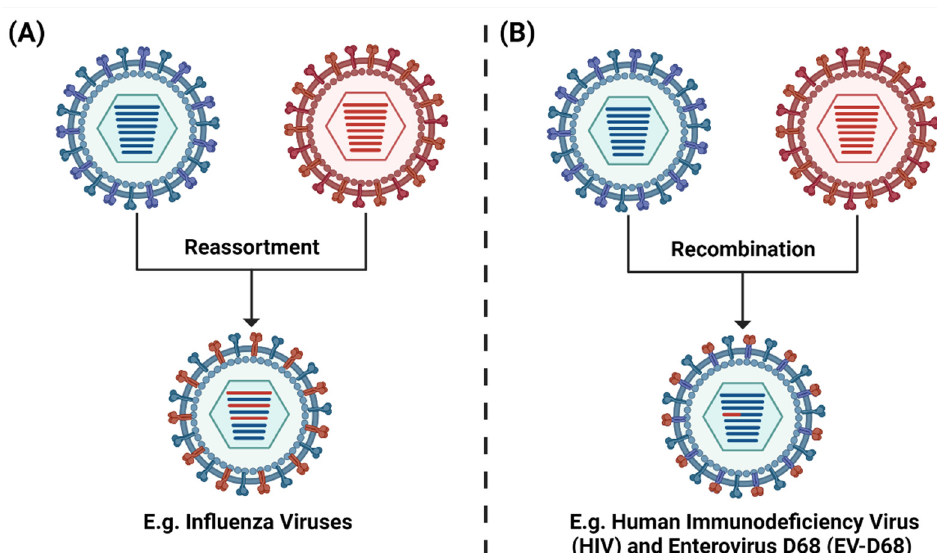
Figure 6. Modes of genetic modification by viruses. ( A ) Reassortment, which only occurs in segmented RNA viruses such as Influenza viruses where two antigenically distinct IAVs co-infect a common cell and reassort their genome segments. ( B ) Recombination, which occurs in all RNA viruses such as Human Immunodeficiency Virus (HIV) and Enterovirus D68 (EV-D68). Created with BioRender.com.